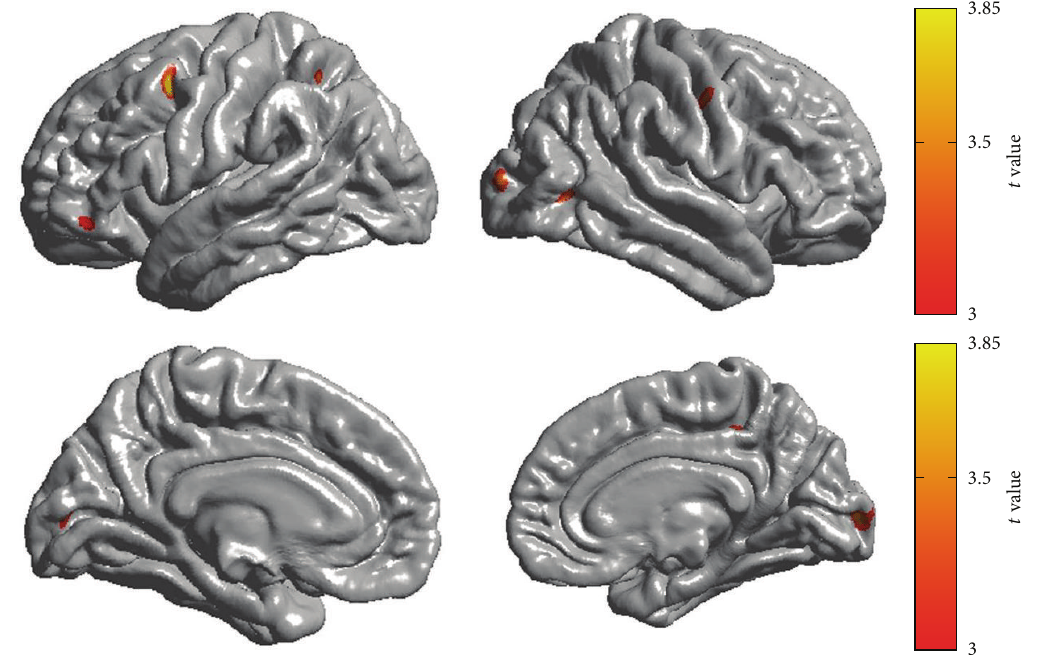
Figure 2: Regional cortical thinning in amputees compared with the controls. 𝑃 < 0.005 ( 𝑡 > 3 ),